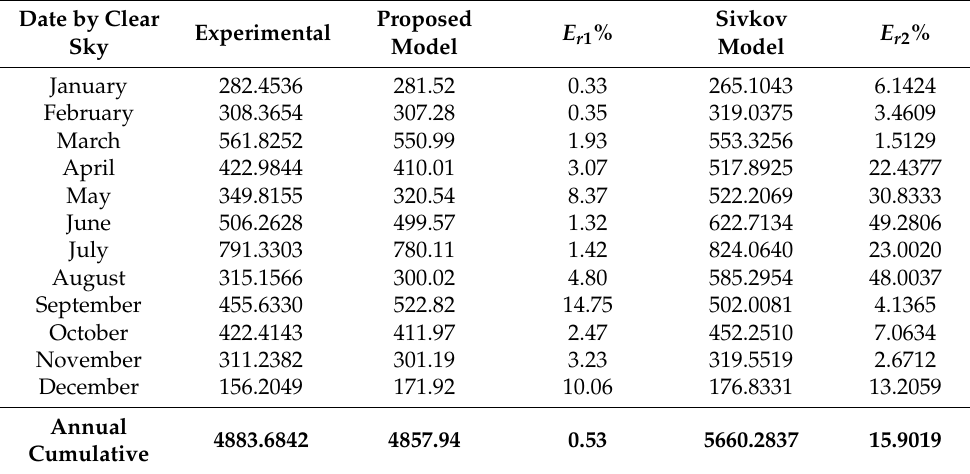
Table 10. The results for Senia site (MJ/m 2